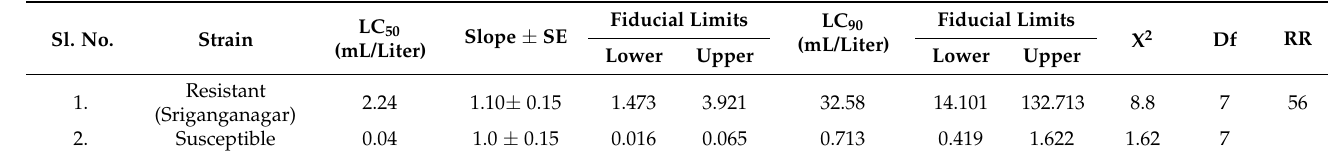
Table 2. Dose mortality of imidacloprid resistant and susceptible strains of CZS against Imidacloprid 17.8 SL.